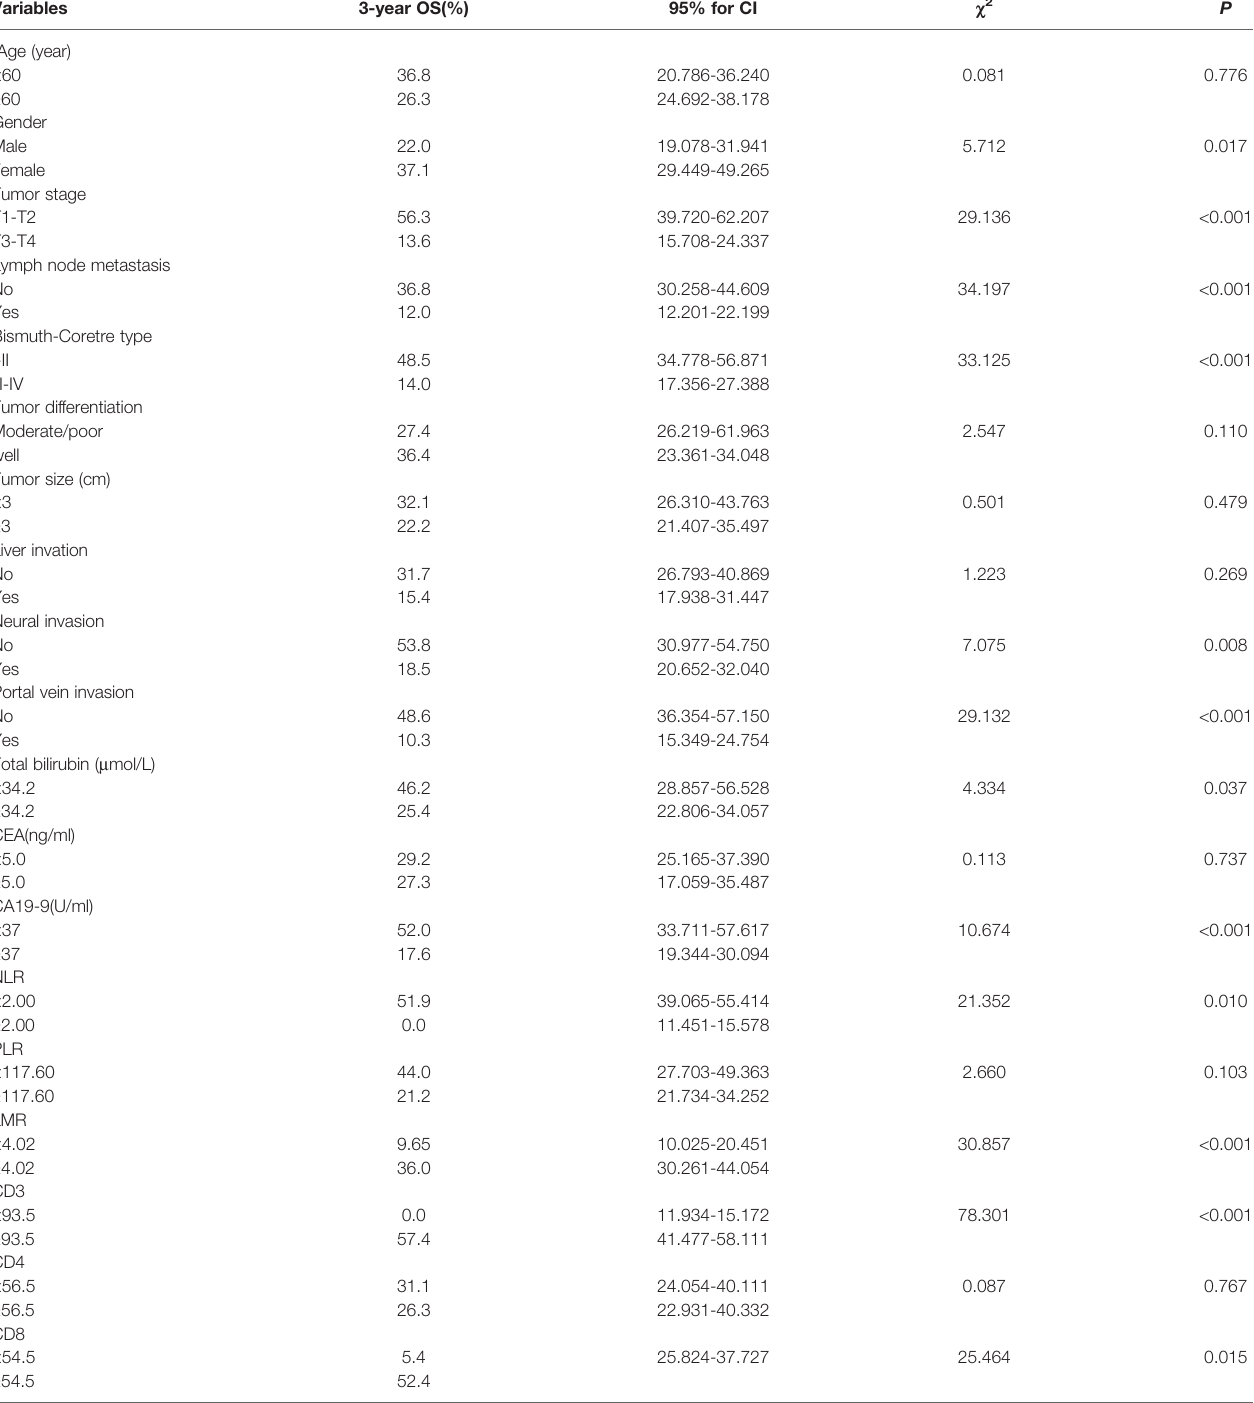
TABLE 3 | Univariate analysis for overall